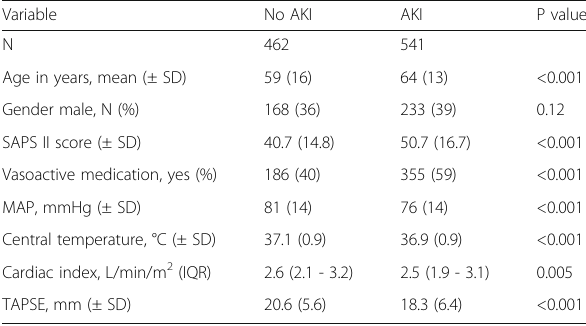
Table 1 (abstract 0063). General patient characteristics and CCUS